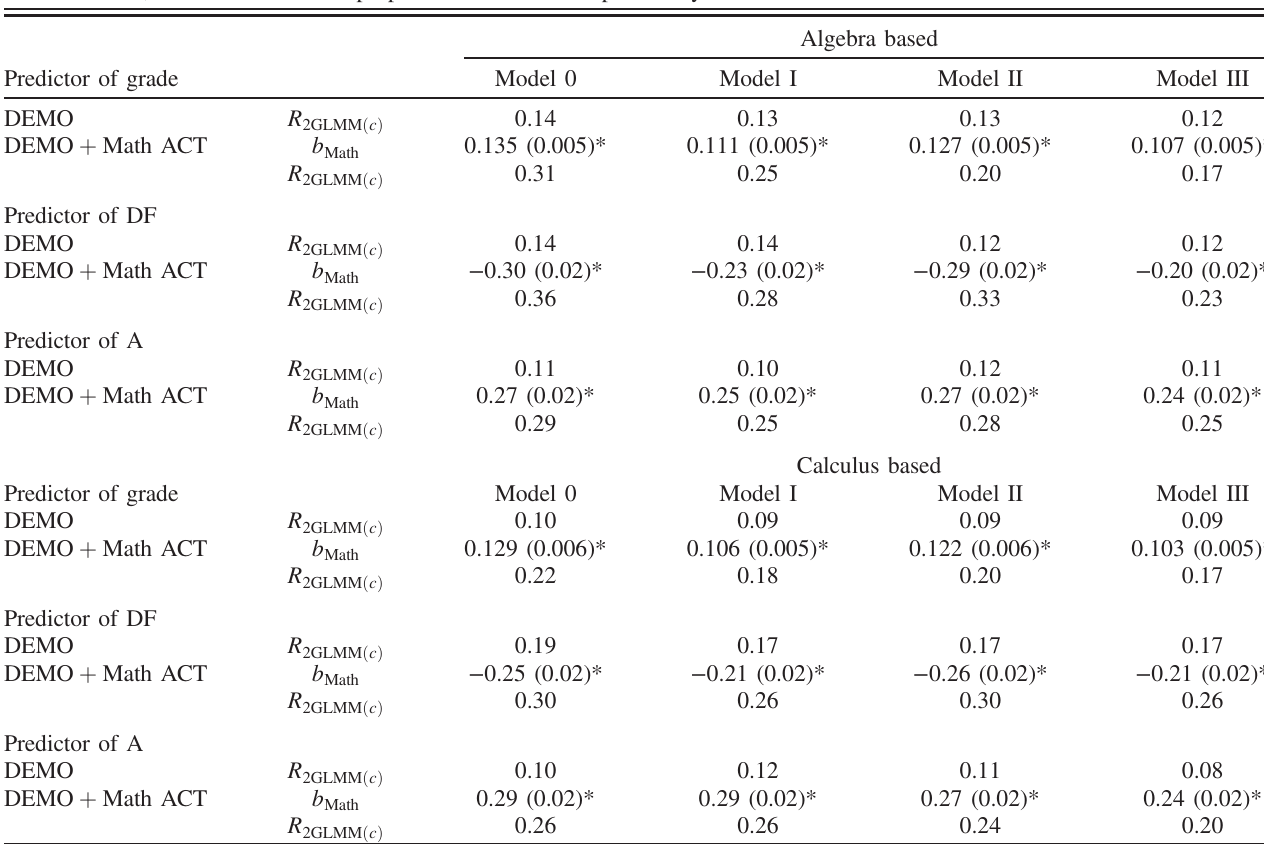
TABLE VIII. Conditional R 2 and regression coefficients of ACT Math using models outlined in Eqs. (1) and (2) with ACT score and without ACT score as a predictor, both times including demographic factors (DEMO ¼ gender, URM, FG, Citizen status, and age) as predictors and lecture section as random effect). The regression coefficients are not normalized, and the R 2 values reported are conditional R 2 , which describes the proportion of variance explained by both the fixed and random